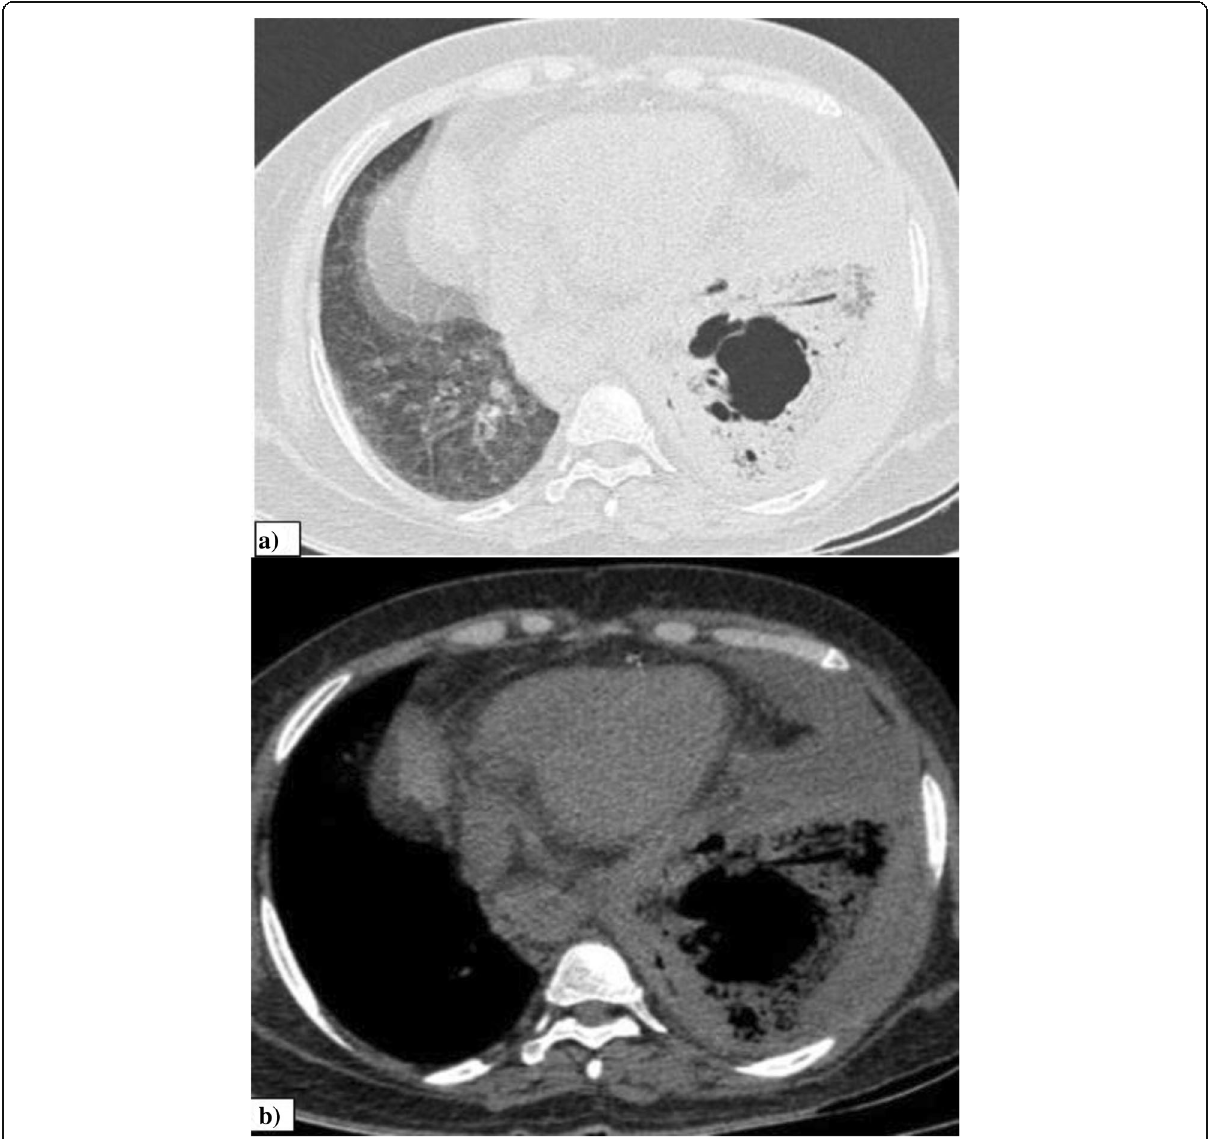
Fig. 9 Necrotizing pneumonia. a , b Axial CT thorax (lung window and mediastinal window) of a 51-year-old COVID pneumonia patient areas of cavitation in the background of consolidation in the left lower lobe. Left pleural effusion also